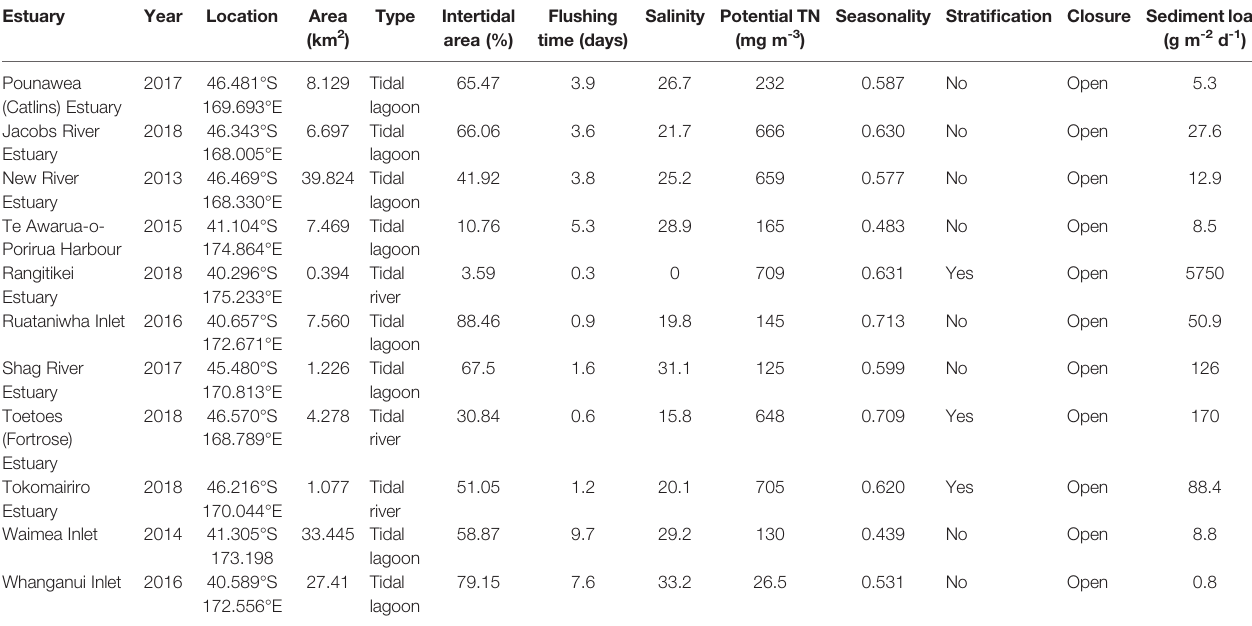
TABLE 2 | Properties of 11 New Zealand (NZ) estuaries, used as Driver node input values to test the ETI Tool 3 BBN. Estuary